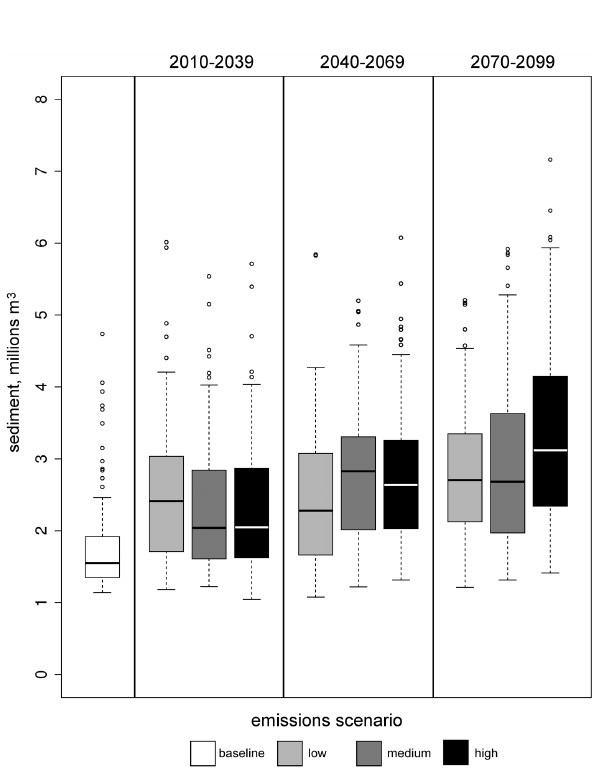
Fig. 4. Box plot showing the distribution of total sediment over 100 30-yr runs using different UKCP09 WG CFs for the 2010–2039, 2040–2069 and 2070–2099 time slices for the Low, Medium and High emissions scenarios. The baseline climate (1961–1990) is shown in white in the left hand panel; the variability in these simu- lations comes from stochastic variability